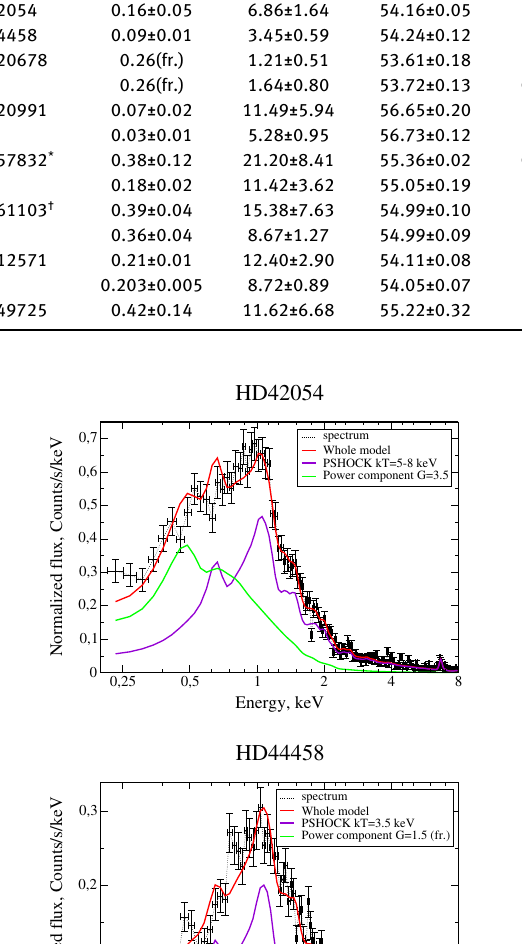
Table 7. The same as in Table 3 but for by PSHOCK+PL models. Star